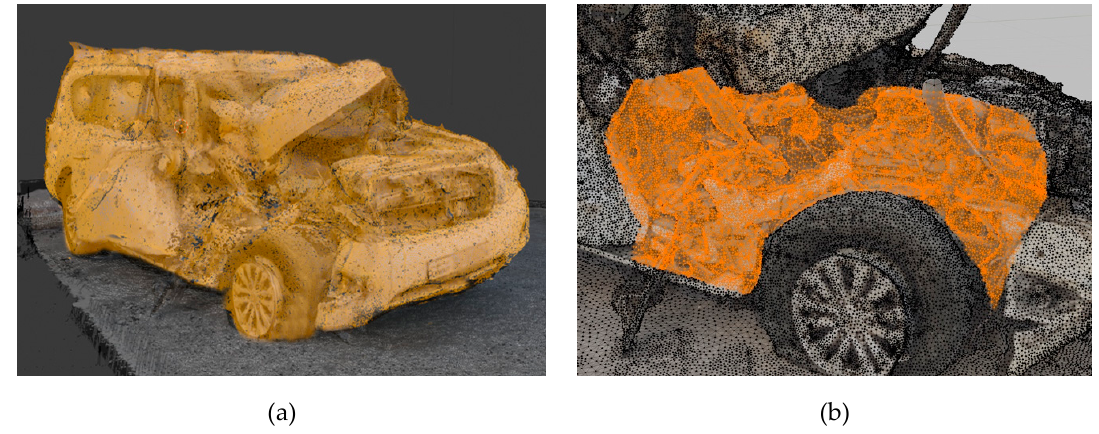
Figure 9. A generated 3D mesh objects of the vehicle 3D model in Blender ( a ) measuring the volume of the whole vehicle body ( b ) measuring the deformation volume of the collided frontal part of the vehicle.